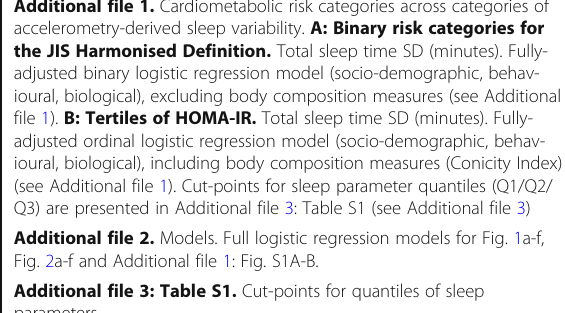
Additional file 3: Table S1. Cut-points for quantiles of sleep